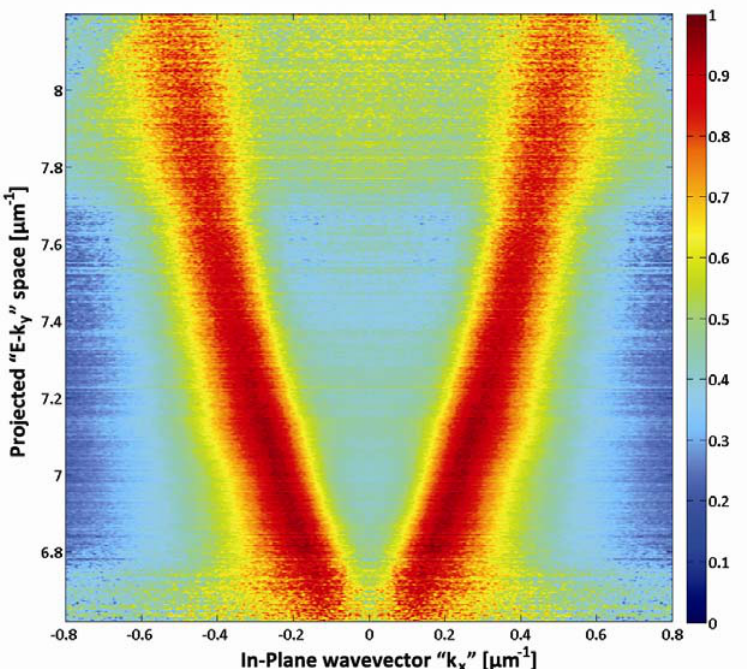
Figure 3. The dispersion relation of the SPR is directly projected on the microscope. The result shows a clear diffraction of SPs, from the ±1st diffraction orders. Measuring the distance between the resonances provides direct information on the surface